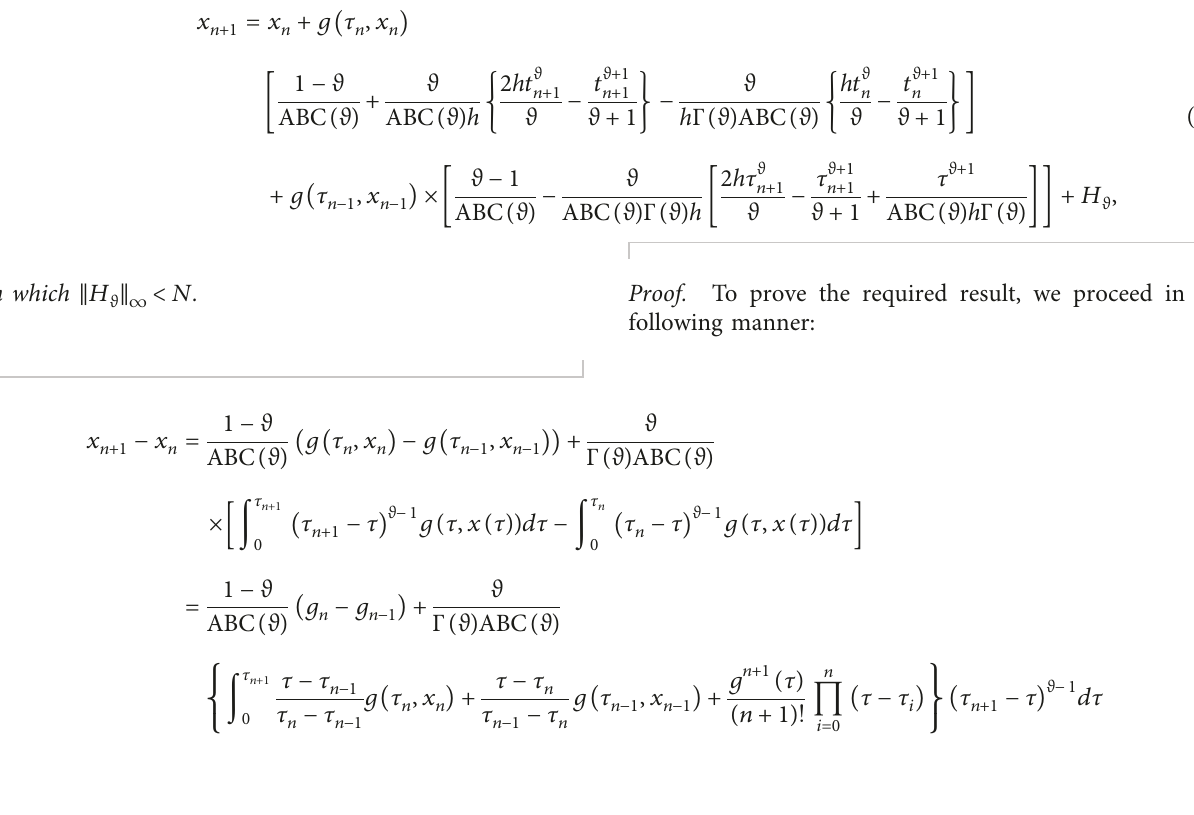
� 0 . 2 , 0 . 25 , 0 . I , i.e., μ I